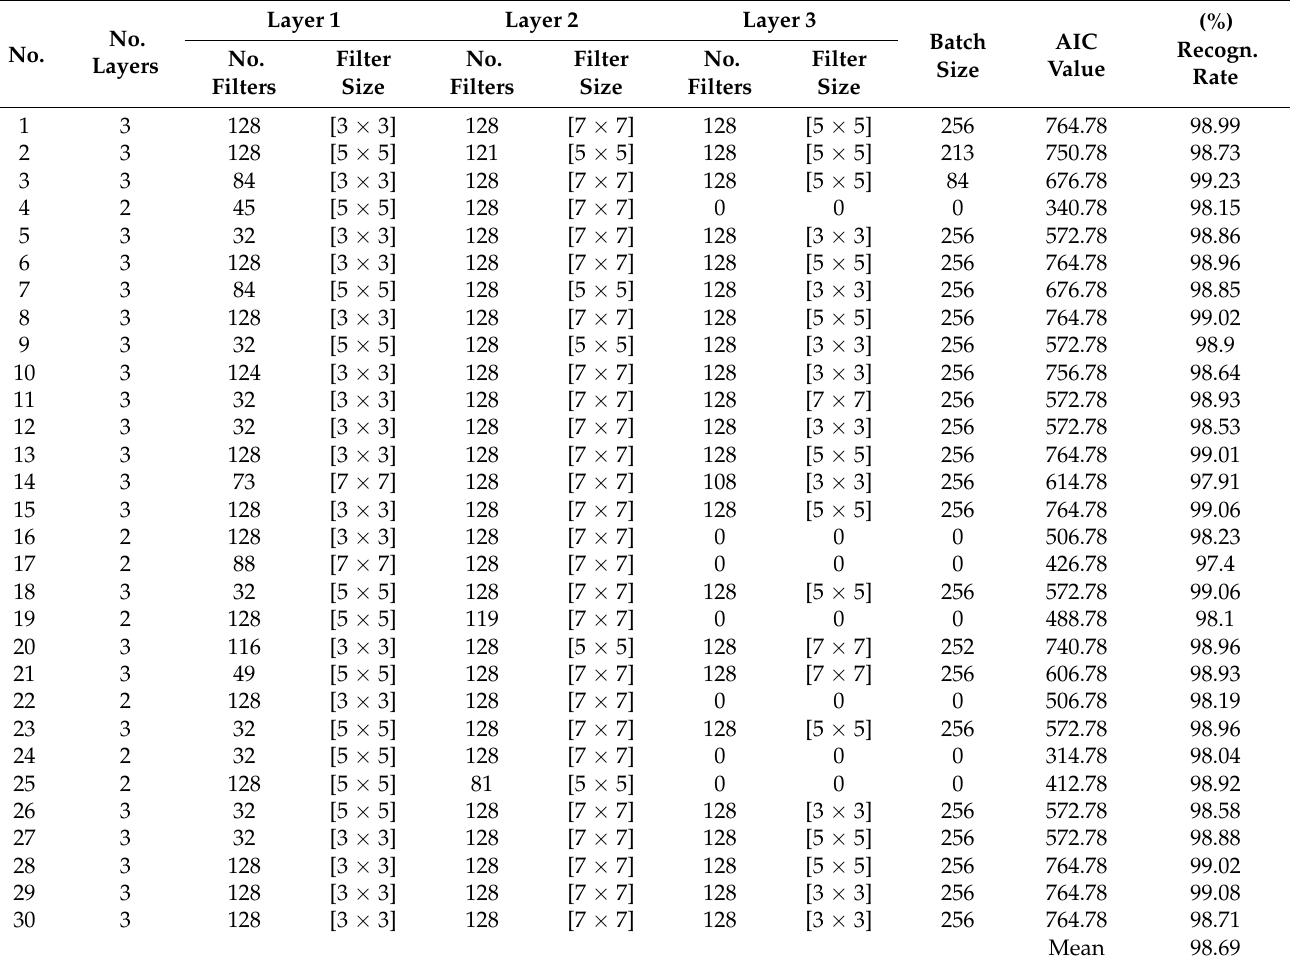
Table 12. Results achieved by the PSO-CNN-II in ASL alphabet